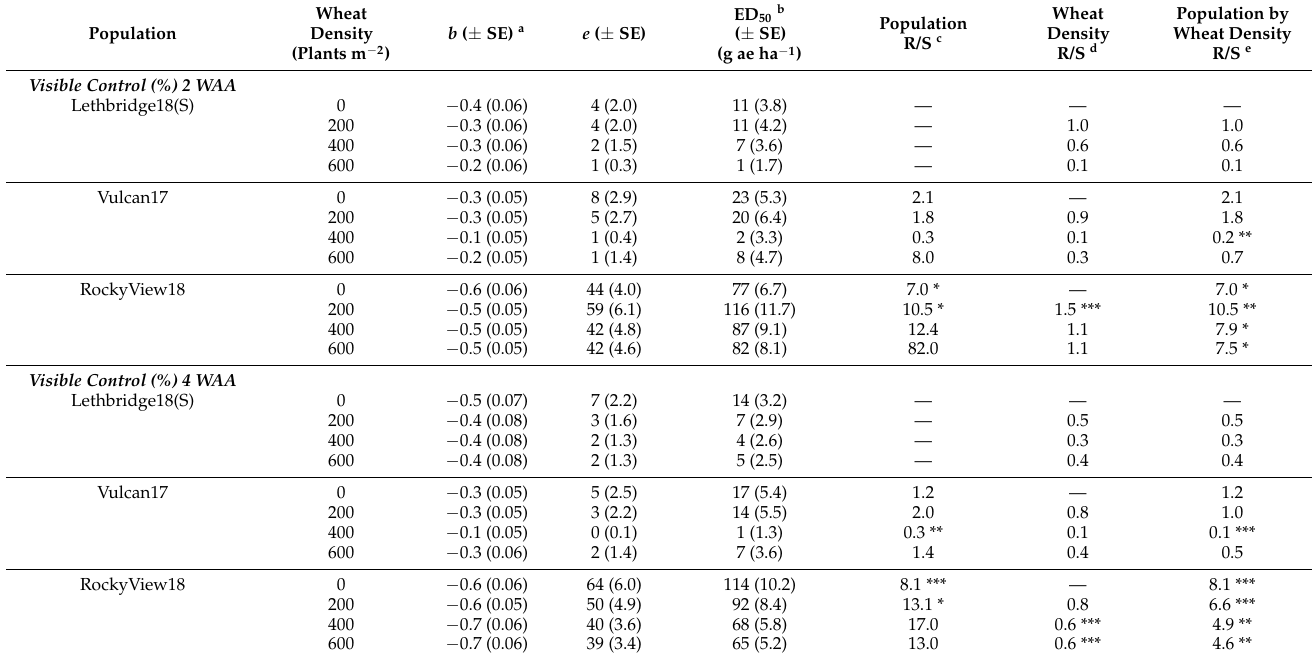
Wheat Population by Density Wheat Density R/S e